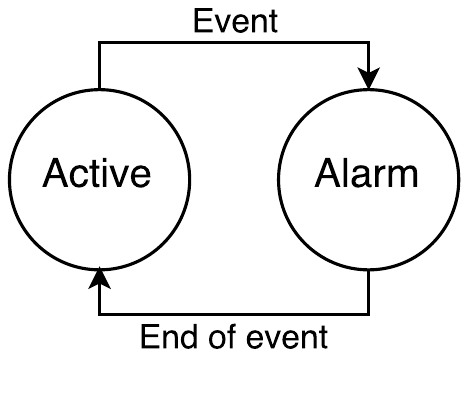
Figure 4. M2M device state transition diagram.